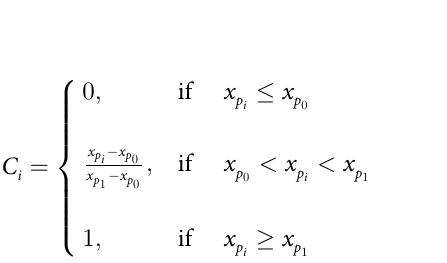
¼ 1 : 5 and ^ b ¼ 0 for illustration. We visualise the corresponding colourmap value ( C i ) 1 0 = ( x , y ) using the Magma colourmap, where black corresponds to C = 0 and bright i i i i using Eq 19 with d = 0.2 and x ¼ 0 : 8 I . i t p max max